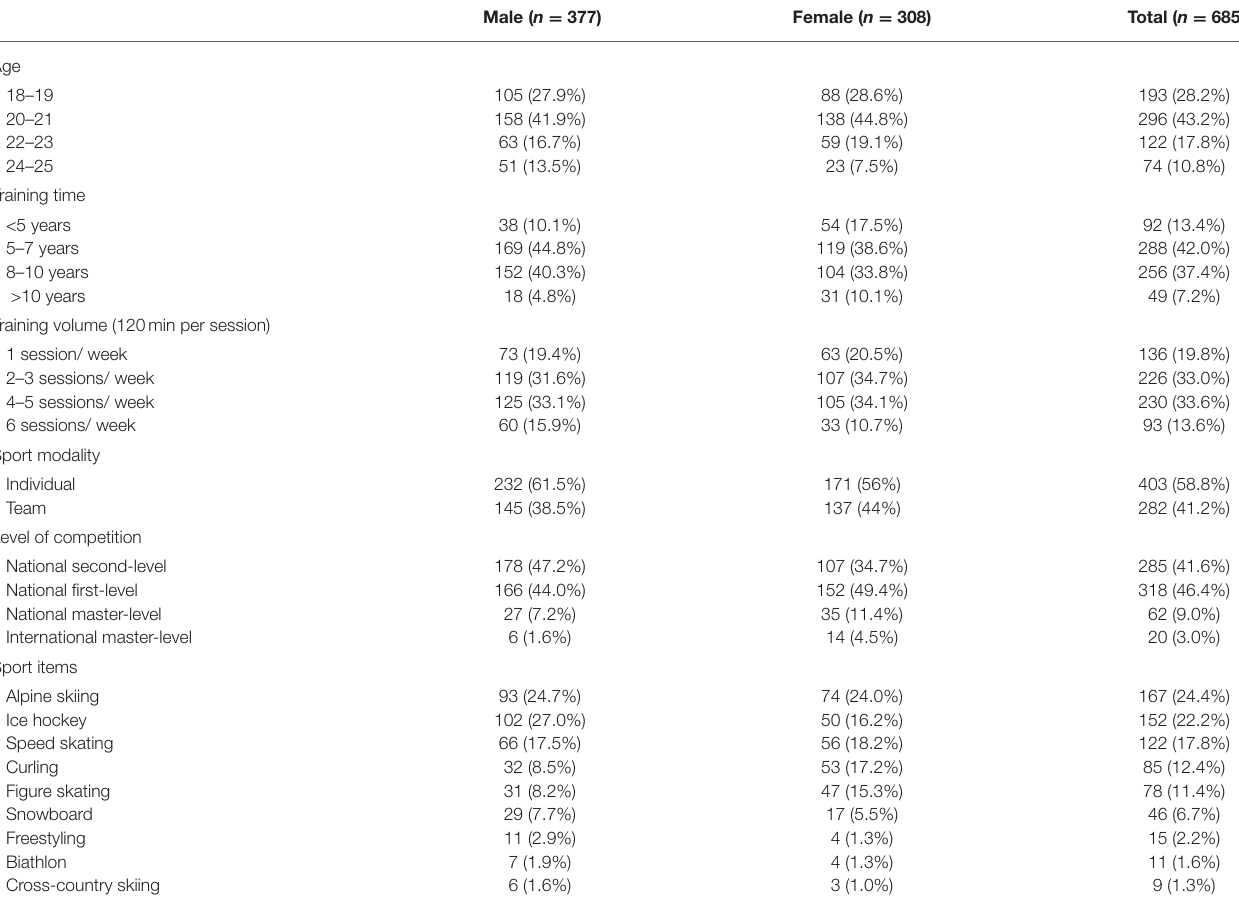
TABLE 1 | Gender, age and training characteristics of the sample of winter sports athletes analyzed in the